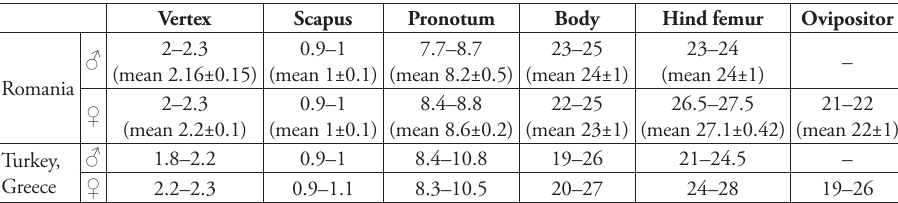
Table 2. Morphological measurements in Parapholidoptera castaneoviridis from south-eastern Romania (n = 3 ♂♂ 4 ♀♀ ), compared with Turkey and Greece (data from Çiplak 2000). All values are given in